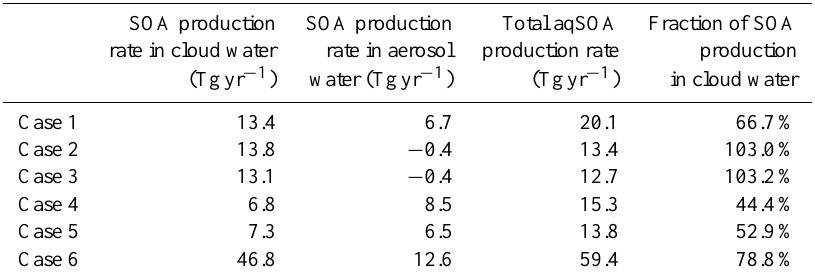
Table 5. aqSOA formation in cloud water vs. aqSOA formation in aerosol